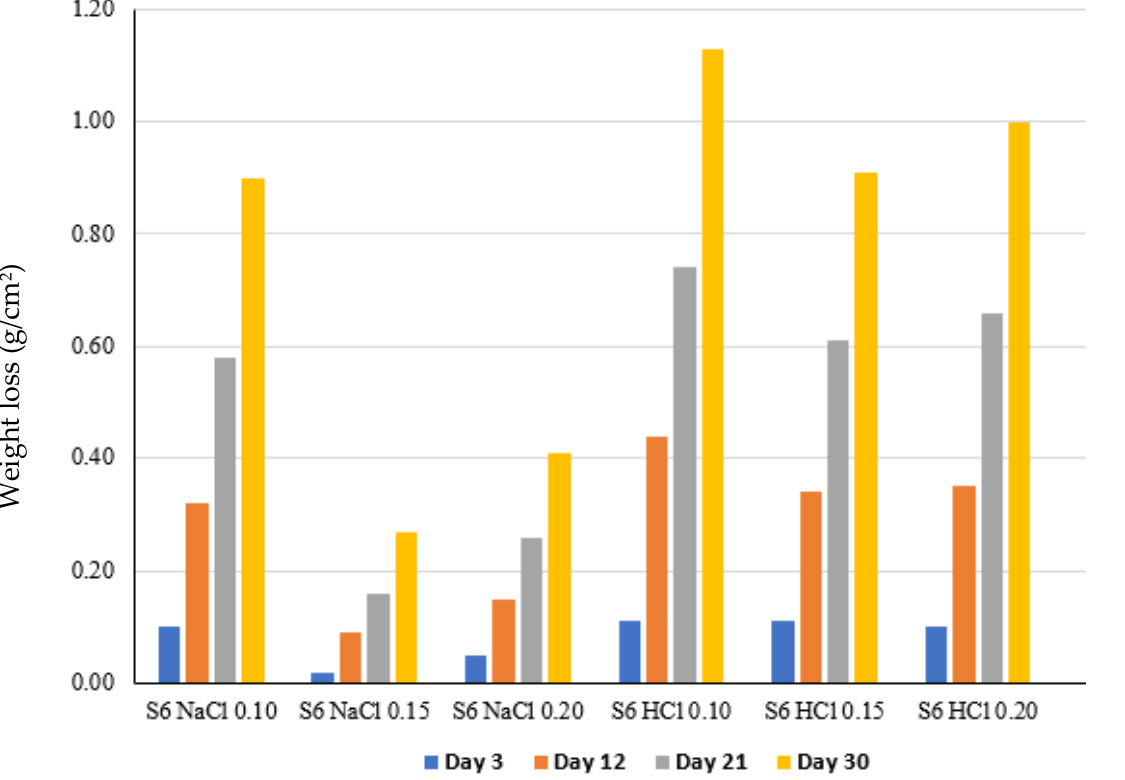
Figure 6. Effect of CaCO 3 on corrosion behaviour of S 6 (6%).